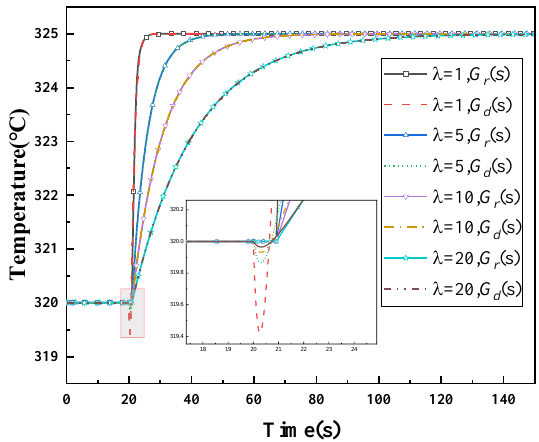
Figure 12. Performance of IMC-PID on different controlled objects.